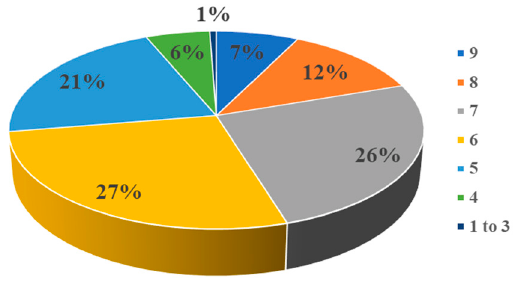
Figure 1. Percentage of each condition level in 2018.